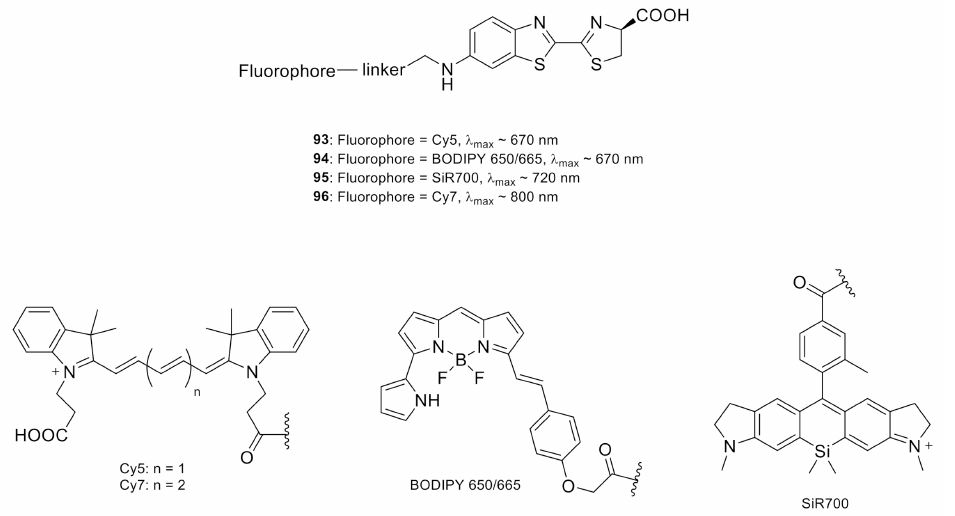
Figure 4. Chemical structures of substrates based on bioluminescence resonance energy trans- fer